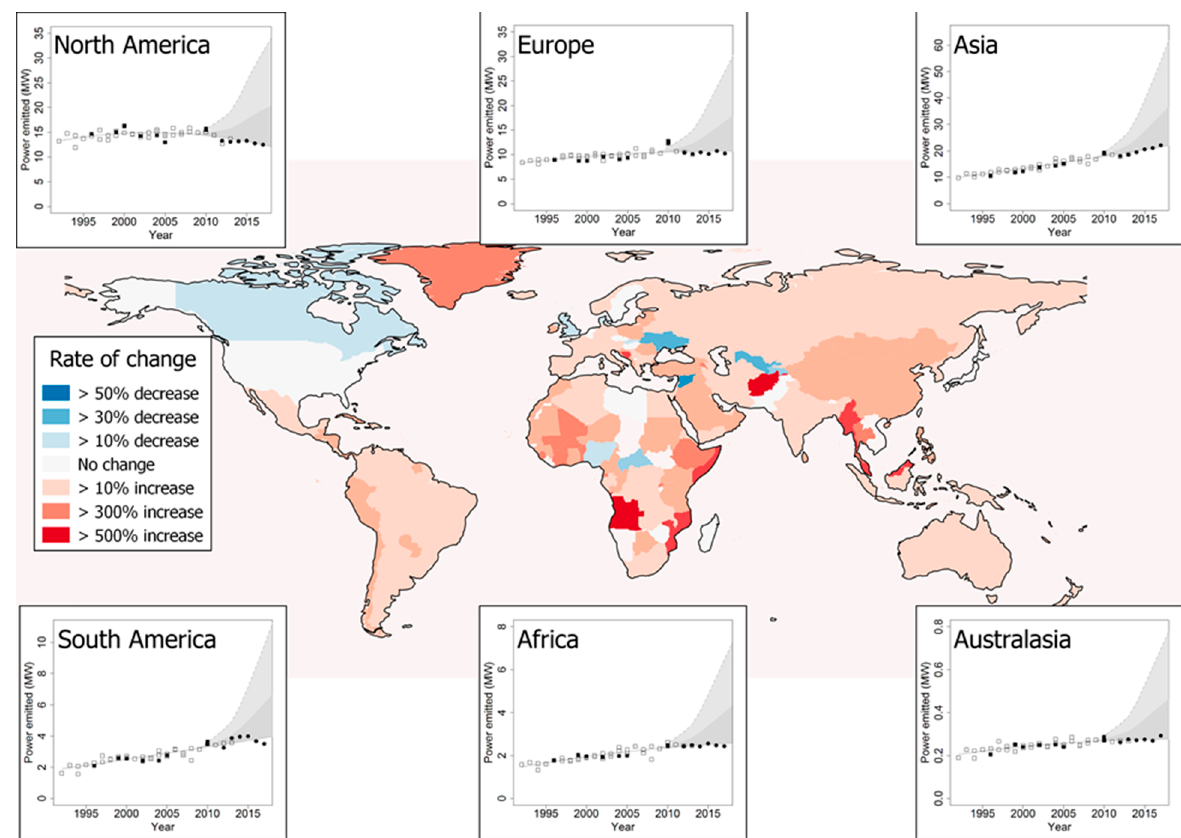
Figure 2. Rate of change in artificial light at night represented as power output detectable by satellites from 1992 to 2017 assessed across countries (map) and continents (inset plots). In plots, open squares represent annual DMSP ‐ OLS composite data, filled squares represent radiance calibrated DMSP ‐ OLS data, filled circles represent VIIRS Day/Night band data. Plotted data points show satellite data assuming constant spectral composition of light emissions. The shaded areas represent the possible range of undetected light assuming a recent phased transition from high pressure sodium lighting to LEDs of color temperature 3000 K (dark grey) or 4000 K (light grey).